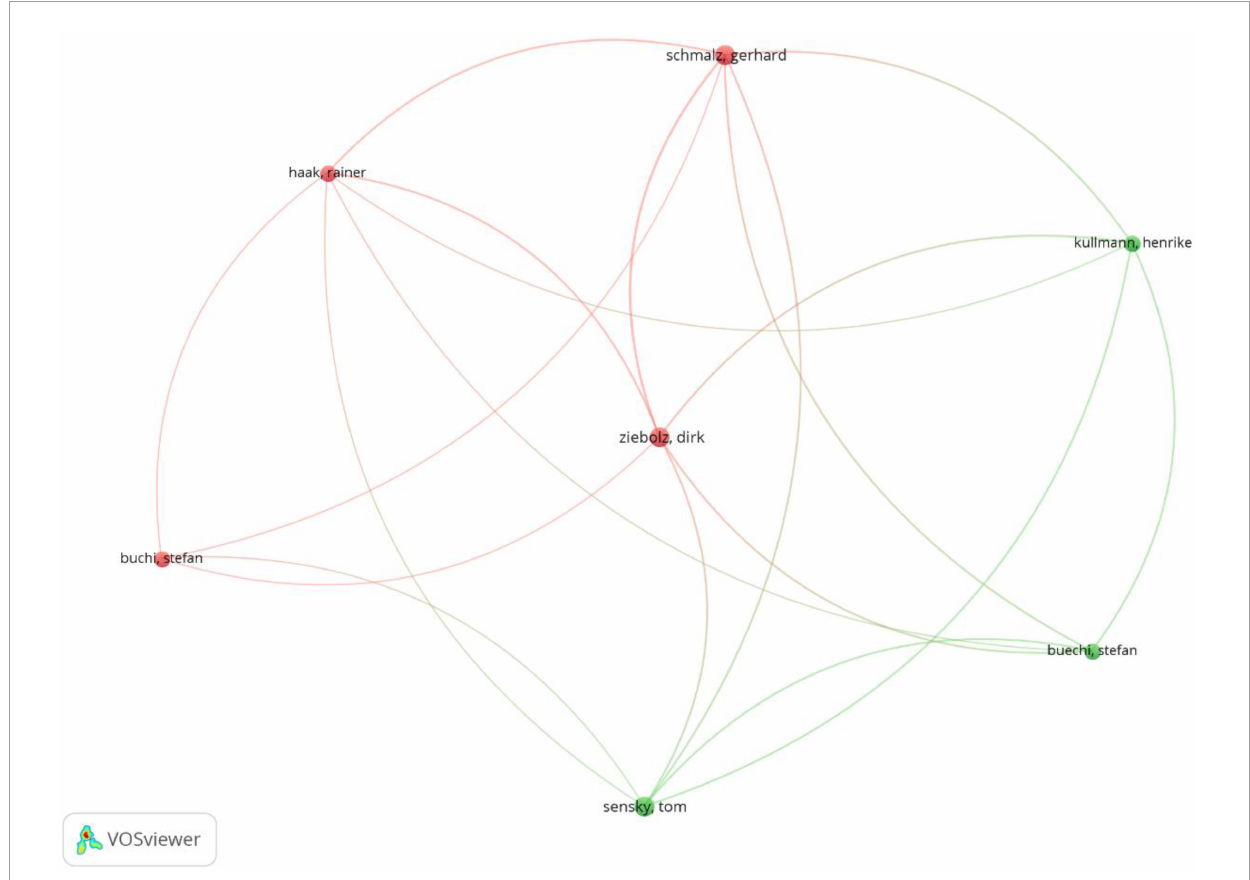
FIGURE6 Co-authorship of authors (min number of citations of an author = 2; visualization by weight of documents).